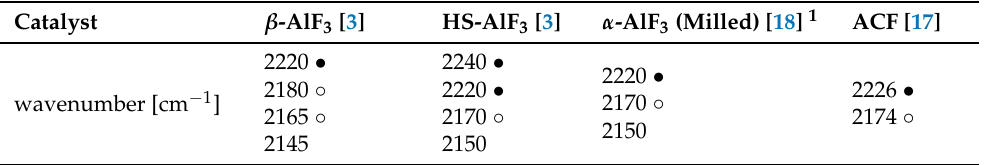
Table 1. Experimental CO frequencies on adsorption on AlF 3 and ACF. Frequency of the free CO